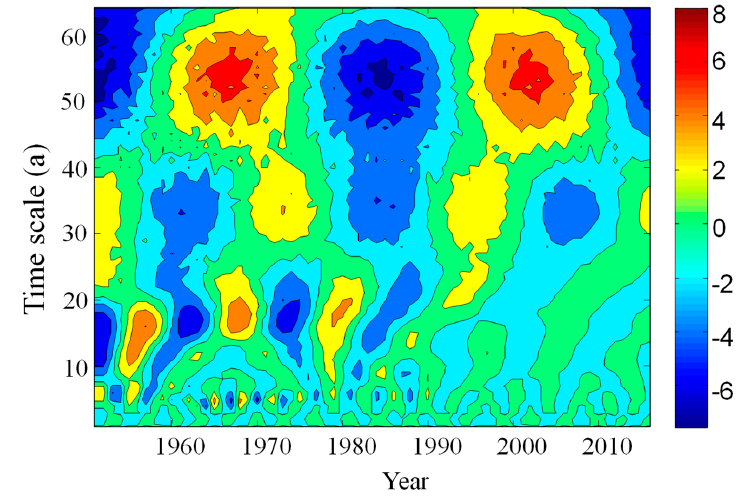
Figure 7. Real part contour map of wavelet coefficients of sediment discharge at Tongguan station.